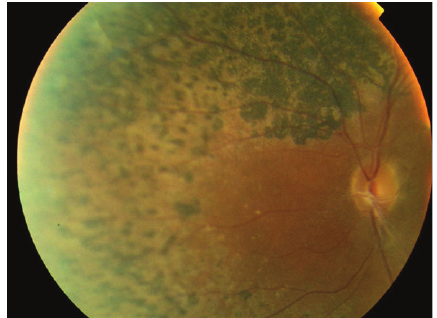
Figure 5: Image of the fundus showing retinitis pigmentosa: pigmentary deposits with attenuation of the retinal